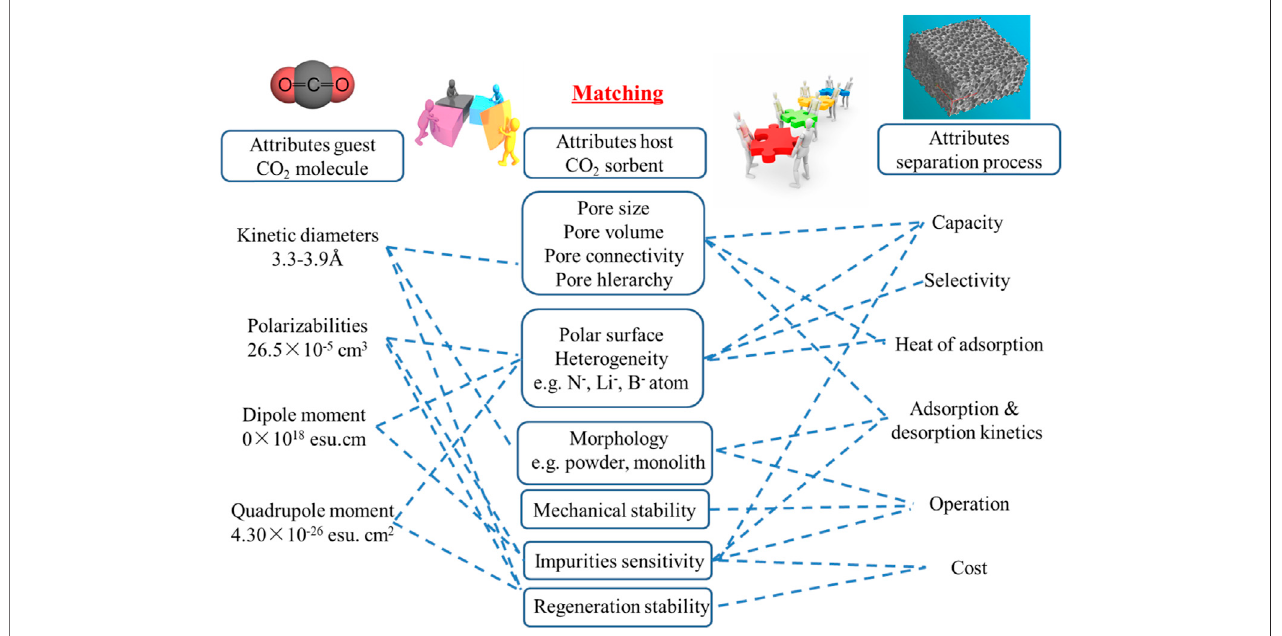
FIGURE 10 | Design criteria for high-performance absorbent